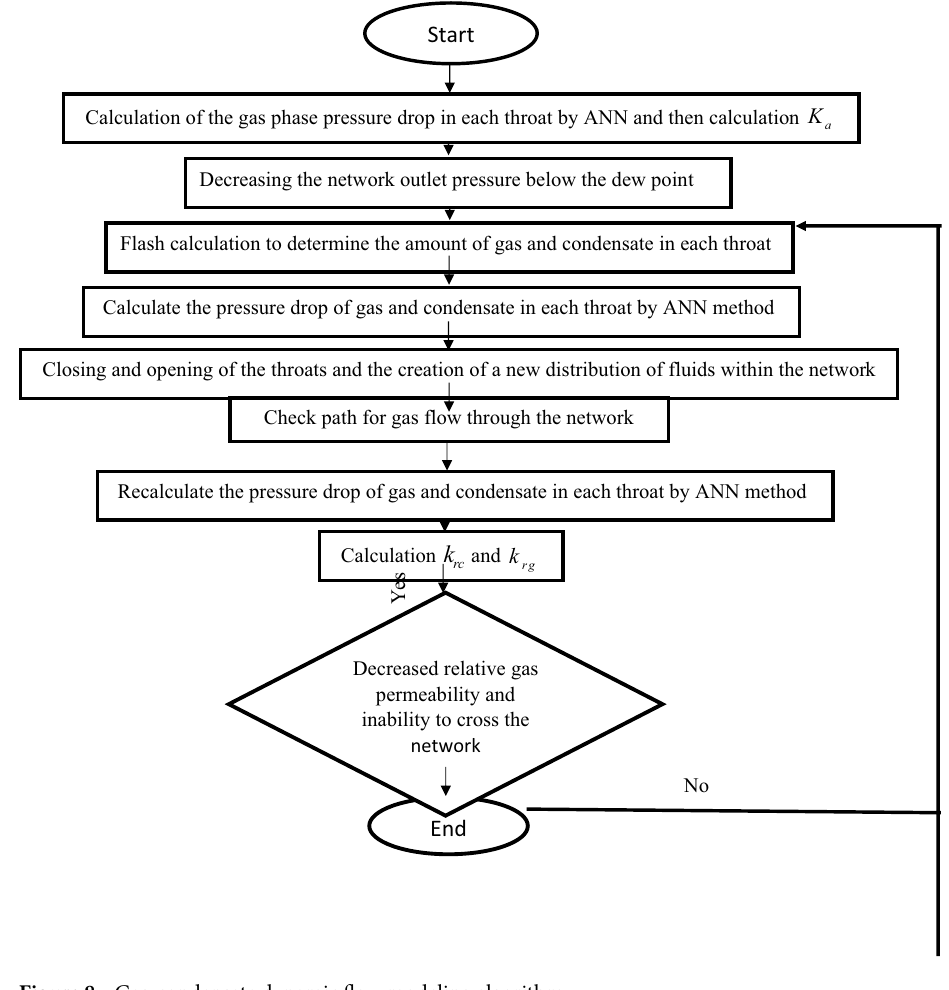
Figure 8. Gas-condensate dynamic flow modeling